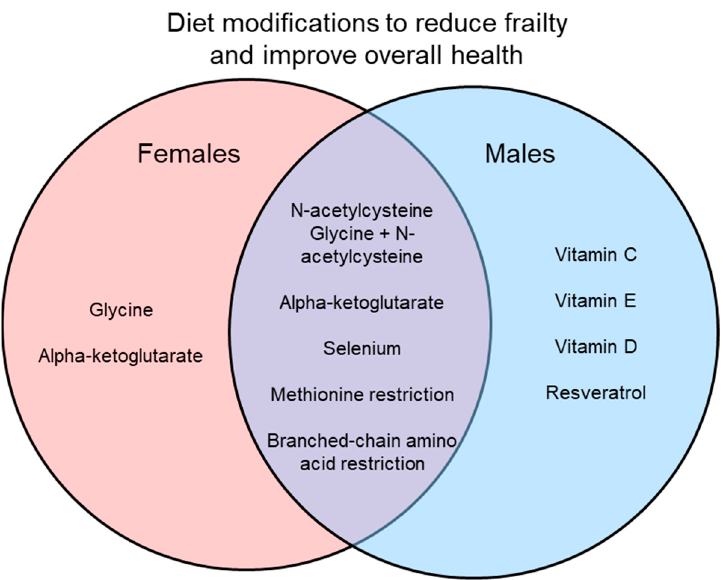
Figure 2. Interventions that improve markers of overall health and attenuate frailty in males, females, or both.